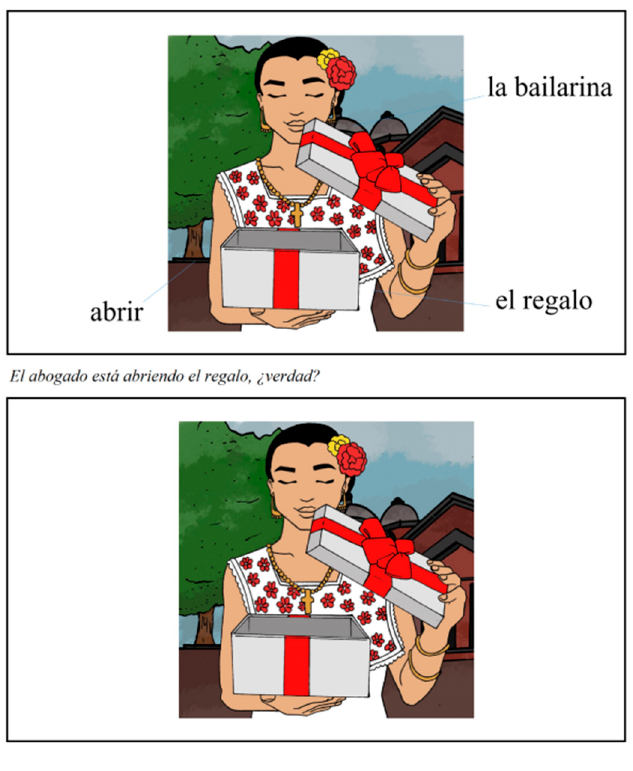
Figure 2. Example from the production task. Above: slide with lexical items. Below: slide plus researcher’s question to elicit contrastive focus on the subject (Translation: ‘The lawyer is opening the present, right?’).